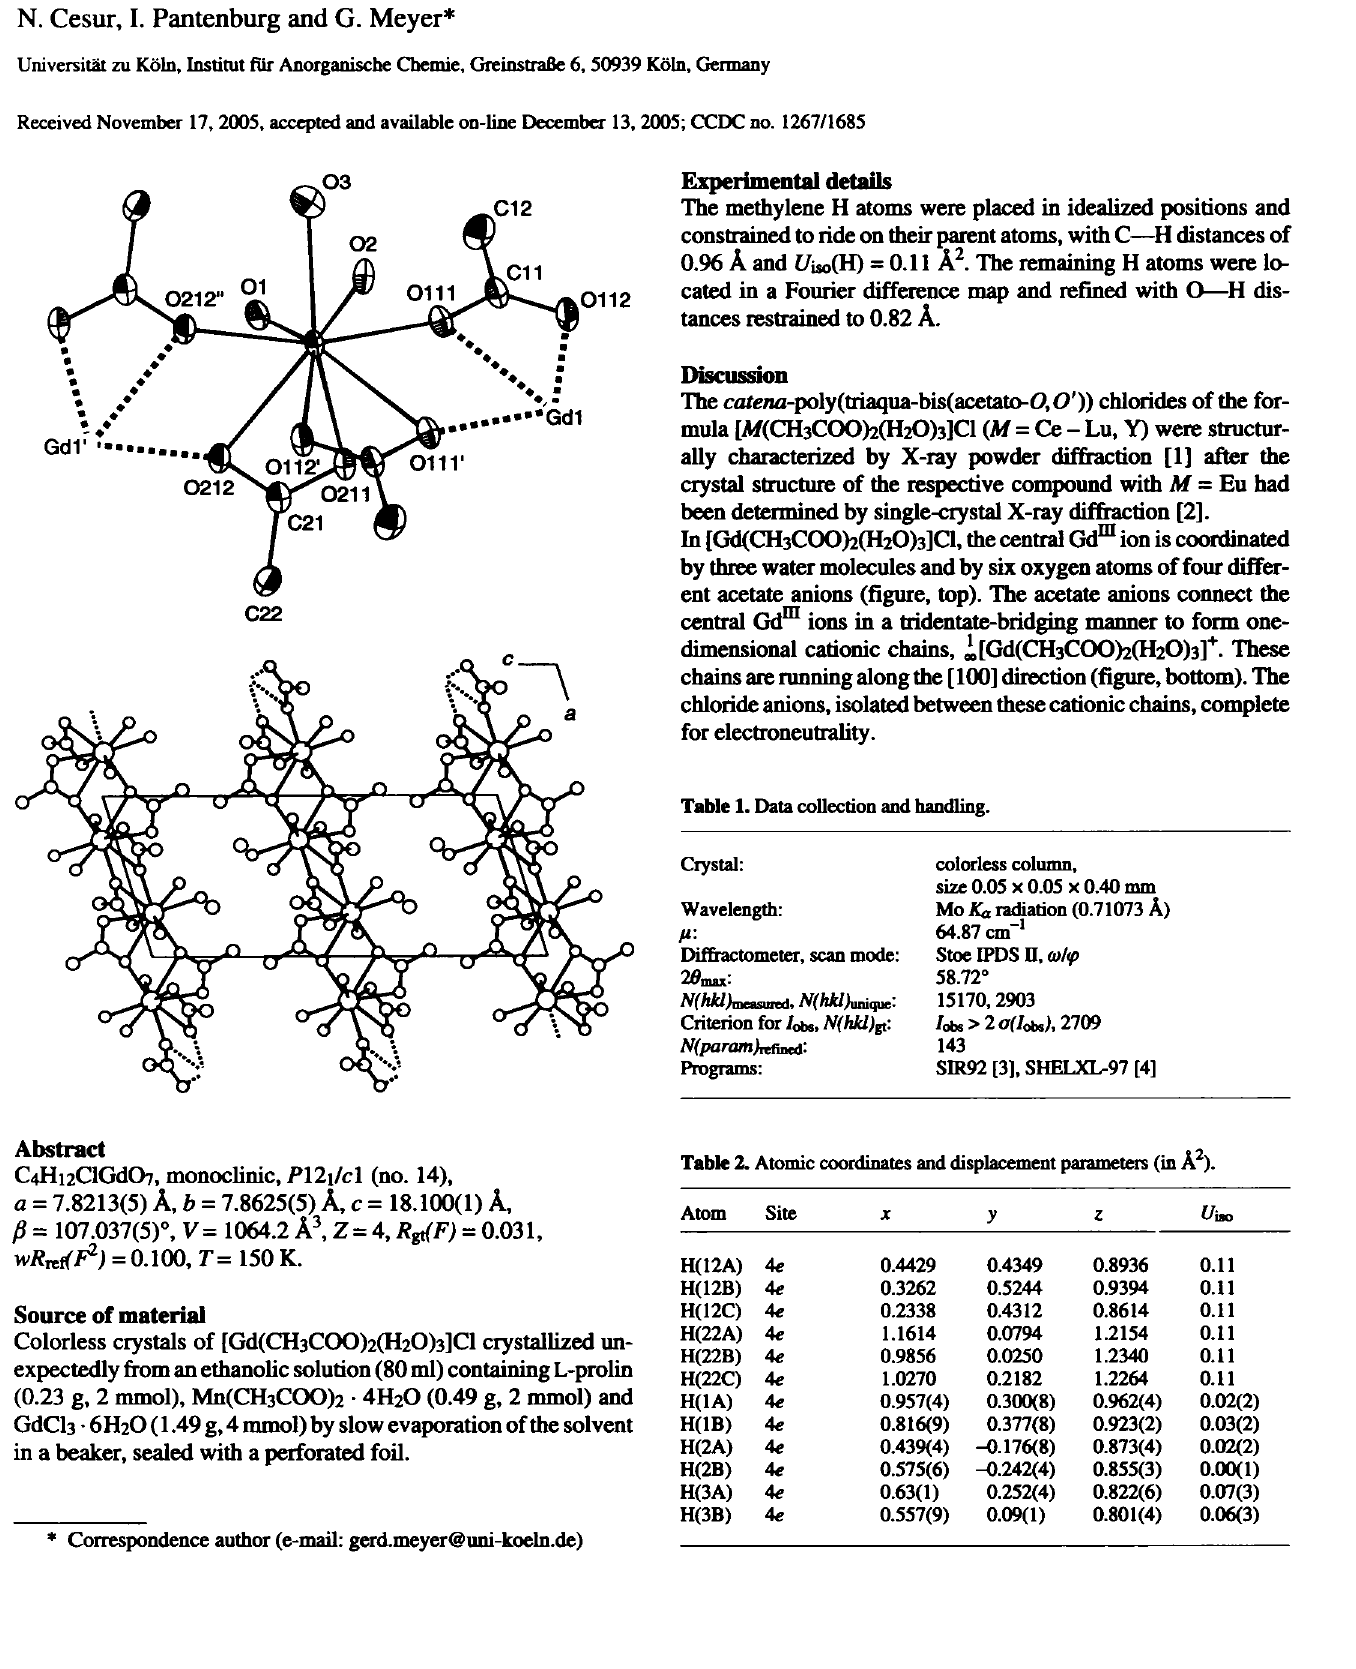
Table 1. Data collection and handling.